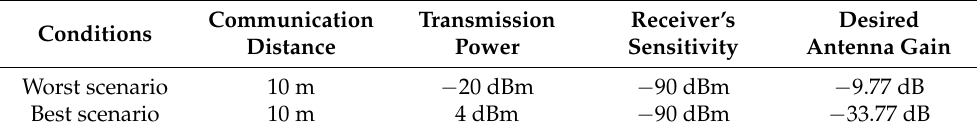
Table 2. Calculation of desired antenna gain for different scenarios.